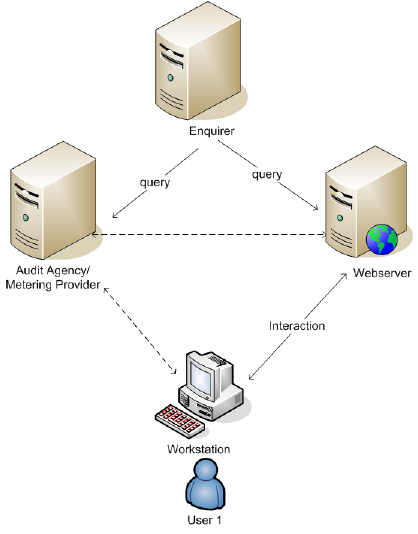
Figure 1. Web Metering